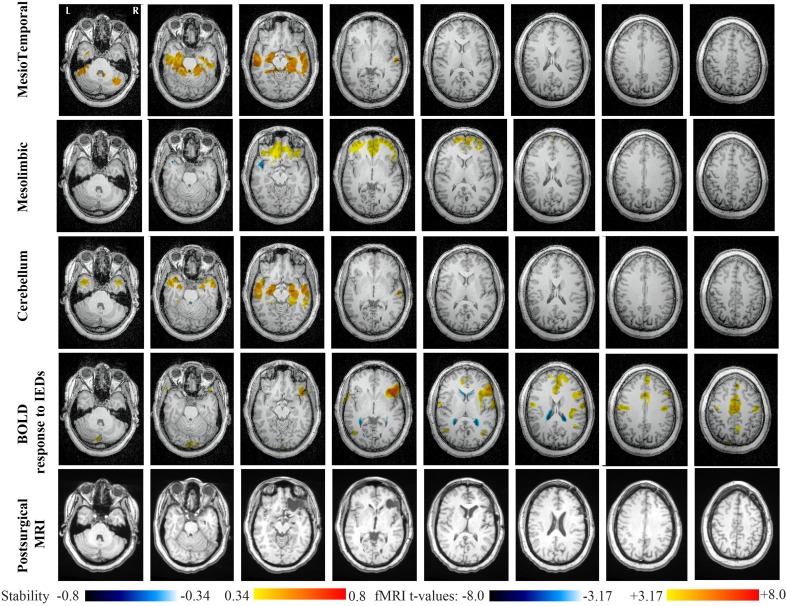
Evaluation of DANI on Patient 1 with right Orbito-Frontal epilepsy. Results are presenting most salient stability changes observed in Cmapn followed by a t-map of the BOLD response to epileptic discharges and a postsurgical T1 MRI, all resampled in the native anatomical MRI space of the patient. Most salient stability changes observed for Cmapn of Mesio-Temporal, Mesolimbic, and Cerebellum networks are presented. These three networks were also involved in significant interactions of modularity changes at p < 0.001. Cmapn are presented between 0.34 and 0.8 (resp. −0.34 and −0.8) and BOLD t-map between 3.17 and 8.0 (resp. −3.17 and −8.0) using a yellow–red colormap (resp. white–blue colormap).